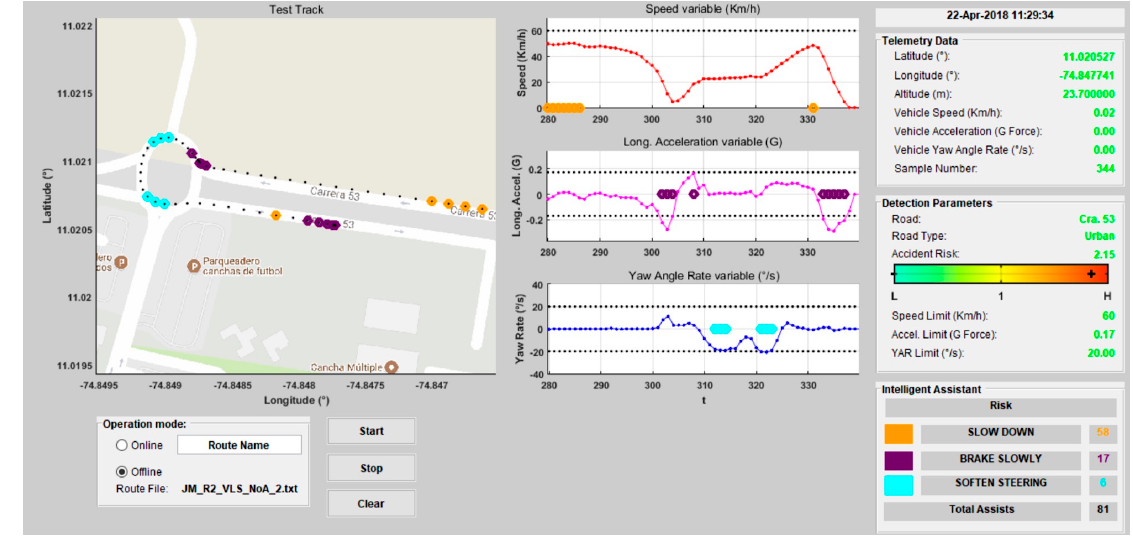
Figure 8. Software interface for Intelligent Driving Assistant (IDA).